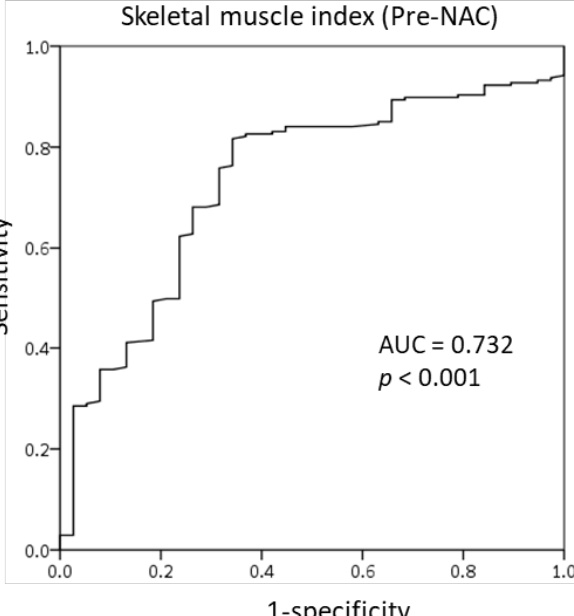
Figure 2. Receiver operating characteristic curve of the skeletal muscle index at the T4 level prior to the initiation of neoadjuvant chemotherapy.